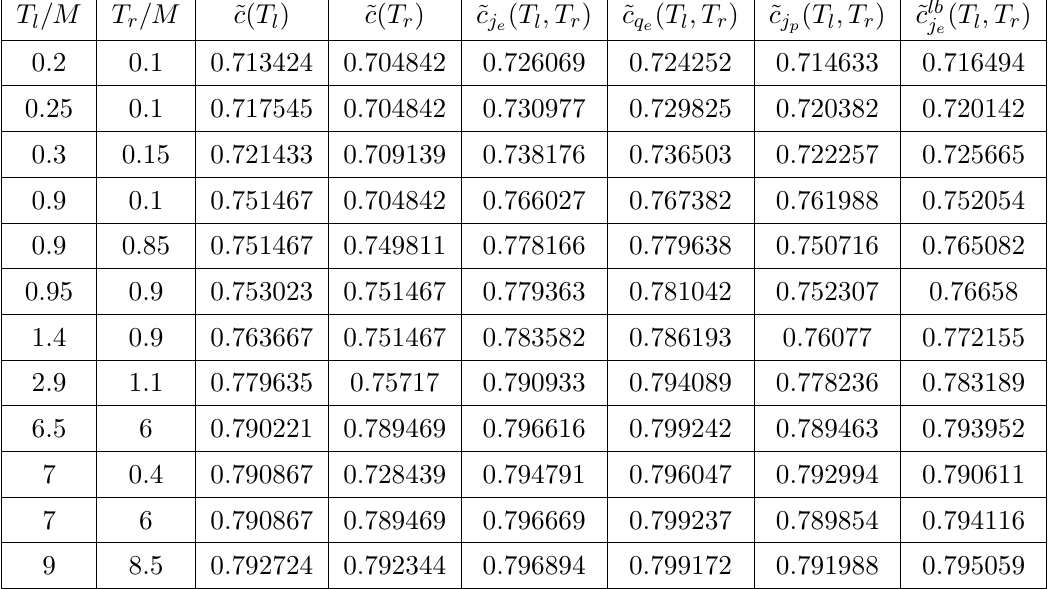
Table 2. The e(cid:11)ective central charges for (left and right) thermal states and the dynamical central charges for the partitioning protocol for various left and right temperatures in the A 3 and D 3 massless (cid:13)ows, where c UV = 0 : 8 and c IR = 0 : 7.